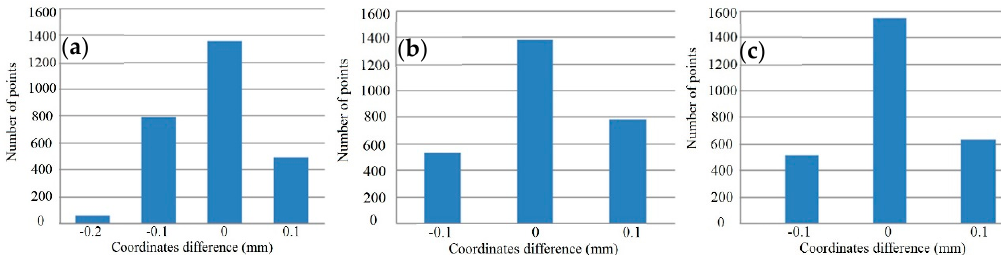
Figure 11. Bar chart of the coordinate difference in the three directions. ( a ) Bar chart of the coordinate difference in the X direction, ( b ) bar chart of the coordinate difference in the Y direction, and ( c ) bar chart of the coordinates difference in the Z direction.